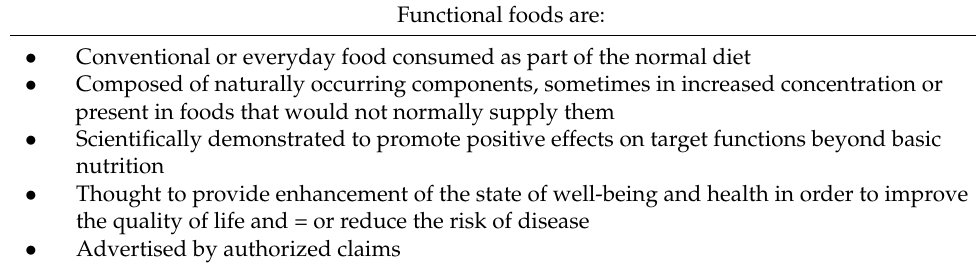
Table 2. The FUFOSE definition of functional food in Europe [13]. Functional foods